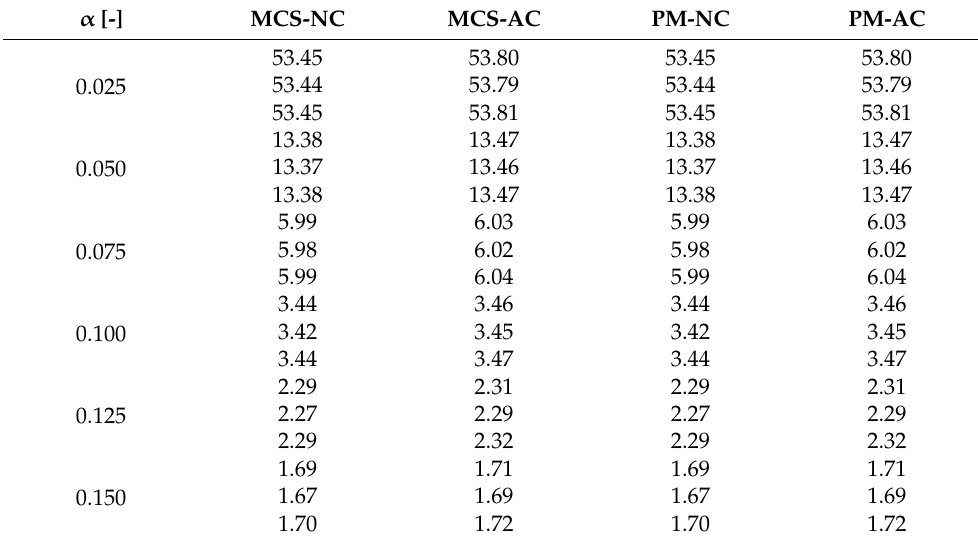
Table 6. A contrast of the estimated reliability indices β ” in the SLS by numerical and analytical methods based upon the Monte Carlo simulation method and the stochastic perturbation technique for the triangular, uniform and Gaussian probability distributions. α